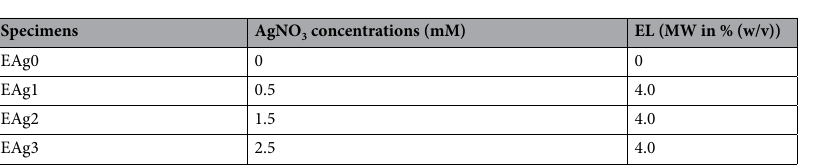
Table 2. Recipe protocols for control and nanosilver-coated sisal/cotton interwoven fabrics. EL European larch heartwood, MW molar weight.